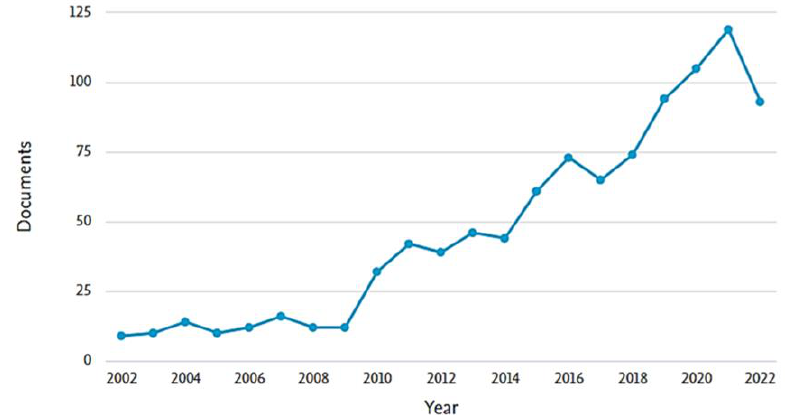
Figure 1. Publication per year in Scopus Database of the last 20 years searching the keywords “UV-Vis spectroscopy” and “chemometrics”.